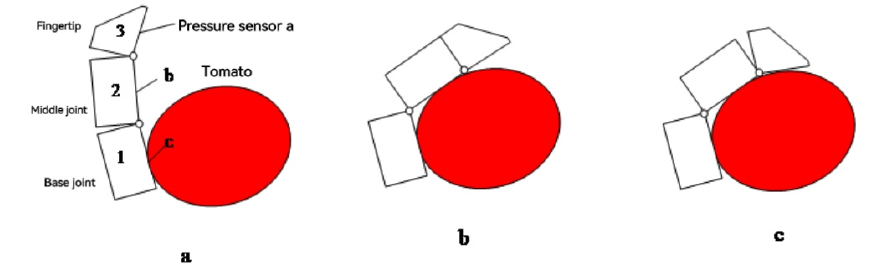
Figure 5. Tomato bounding and grabbing process.